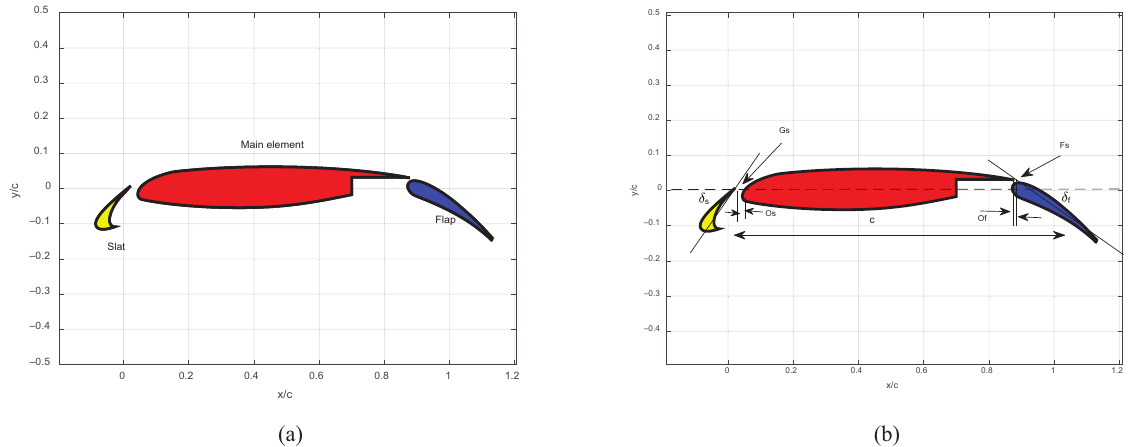
Figure 9. Illustration of 30P30N airfoil (a) Geometry (b) leading edge slat, trailing edge flap along with deflection angles with respect to chord line